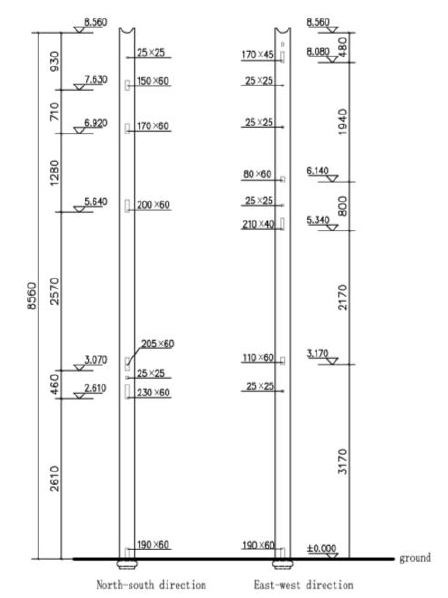
Figure 2. The survey map of the center pillar of the